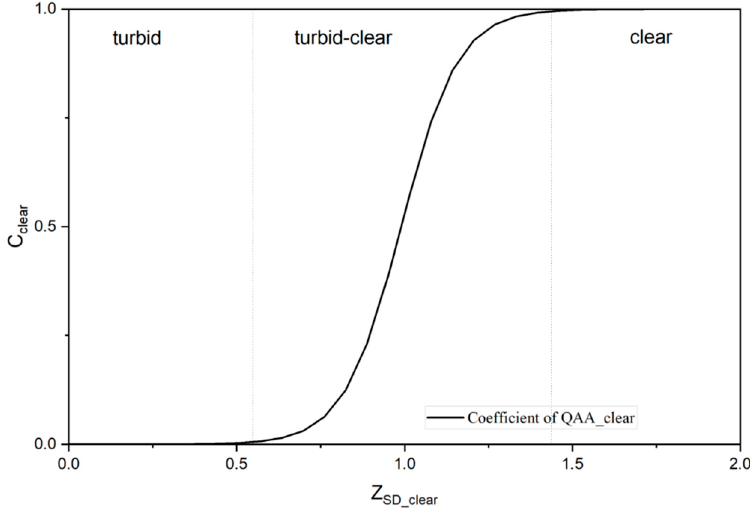
Figure 4. Scatter plots of Landsat-estimated Z SD and in situ-measured Z SD for ( a ) QAA_clear and ( b )